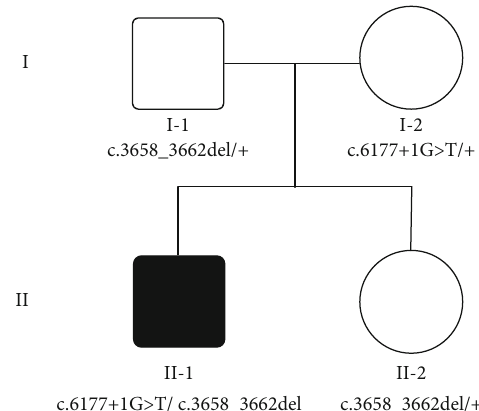
Figure 1: Pedigree and genotype of the Chinese Han family with MYO15A